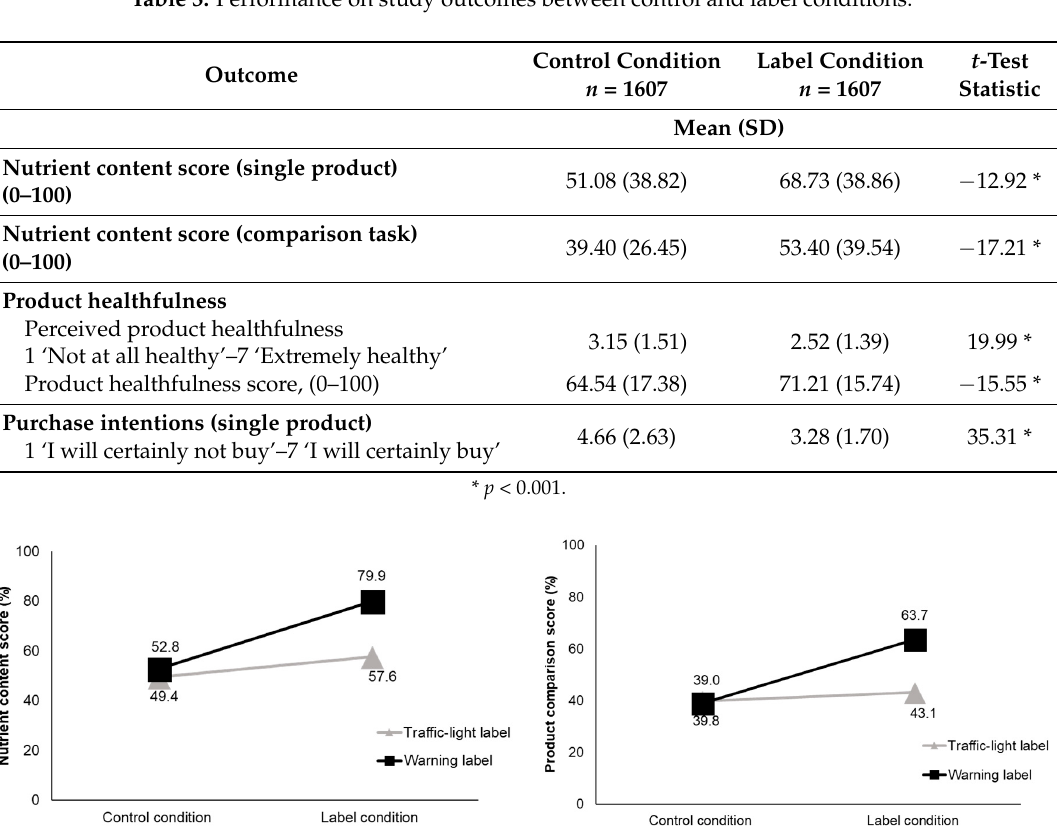
Table 3. Performance on study outcomes between control and label conditions.